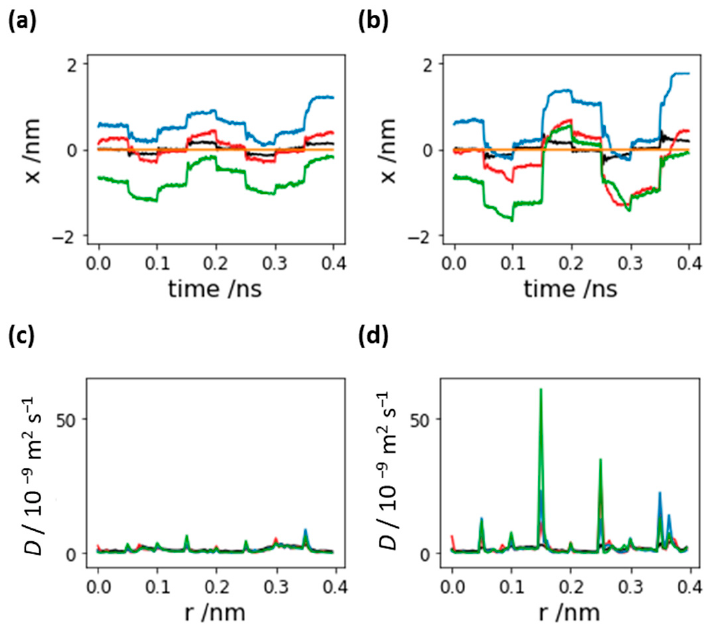
Figure 7. Average ion and water positions over time in the case of ( a ) single-layer graphene and ( b ) bilayer graphene. Self-di ff usion coe ffi cients in the case of ( c ) single-layer graphene and ( d ) bilayer graphene. Li, Na, and K ions, and H 2 O are represented by red, blue, green, and black curves, respectively.